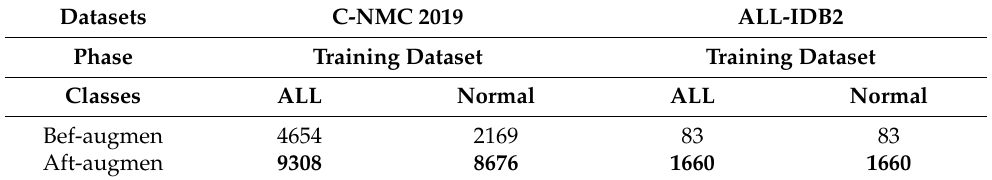
Table 3. Data augmentation method of C-NMC 2019 and ALL-IDB2 datasets for acute